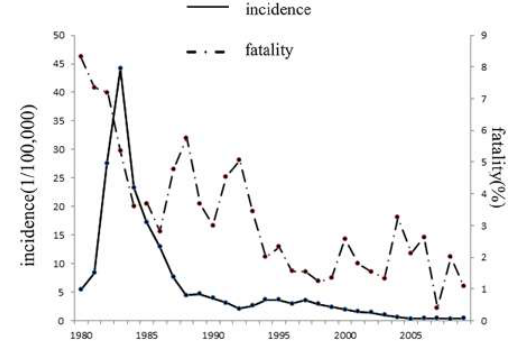
Figure 3. Hubei monthly incidents of HRFS for every five year from 1980 through